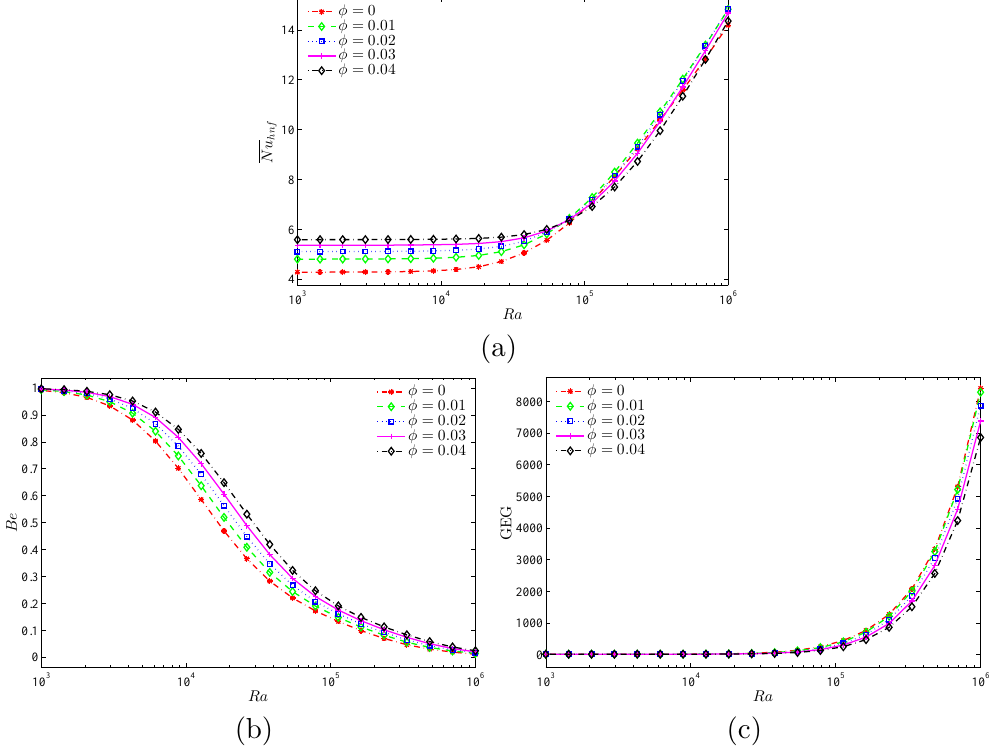
Figure 15. Evaluation of ( a ) average Nusselt number ( Nu ), ( b ) Bejan number ( Be ), and ( c ) the global entropy generation (GEG) with Ra and different φ for hybrid nanofluids and D =